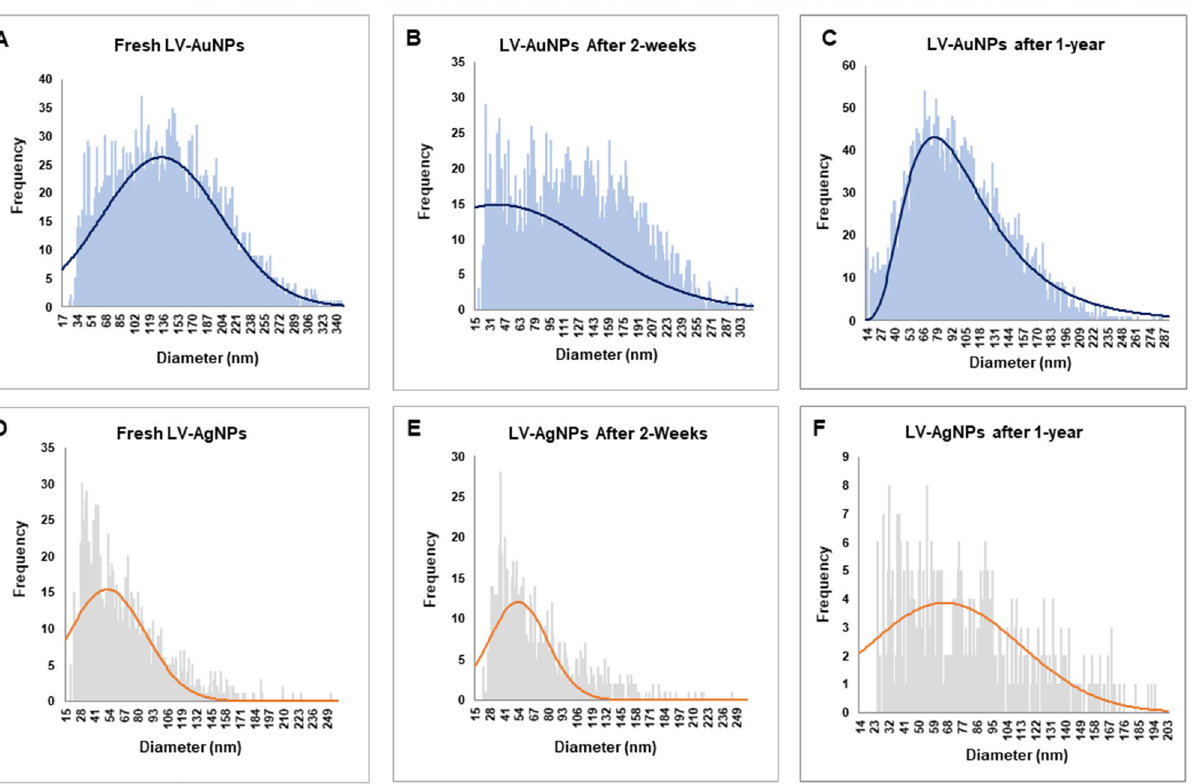
Figure 5. sp-ICPMS and stability analysis of LV-AuNPs and LV-AgNPs. ICPMS histogram of LV-AuNPs at different time intervals (A) fresh LV-AuNPs, (B) after two weeks, (C) after one year at 4 °C. ICPMS histogram of LV-AgNPs at different time intervals (D) fresh LV-AgNPs, (E) after two weeks, (F) after one year at 4